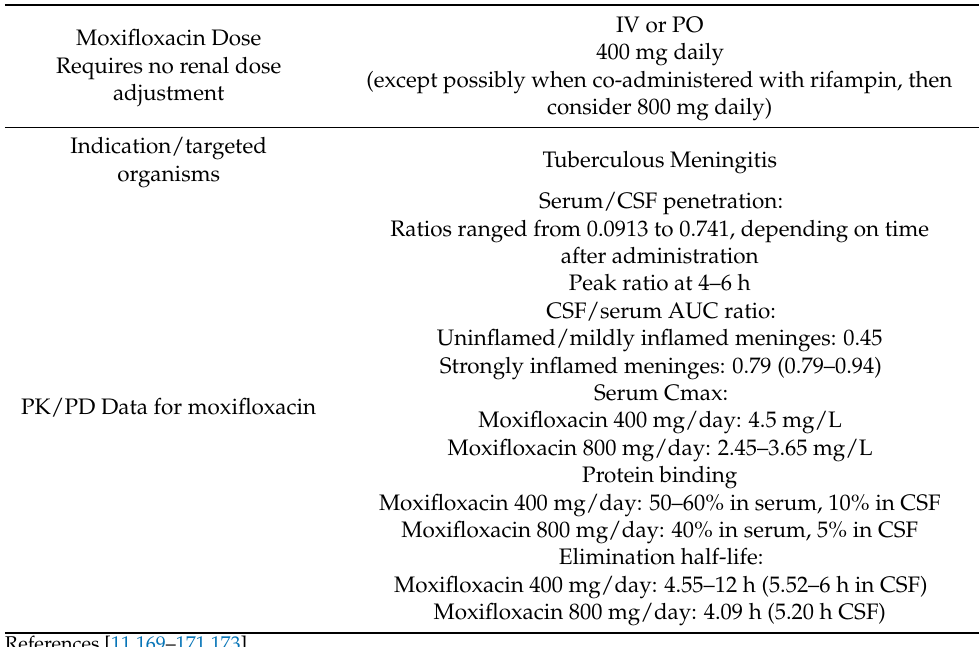
Table 6. Moxifloxacin dosing and PK/PD